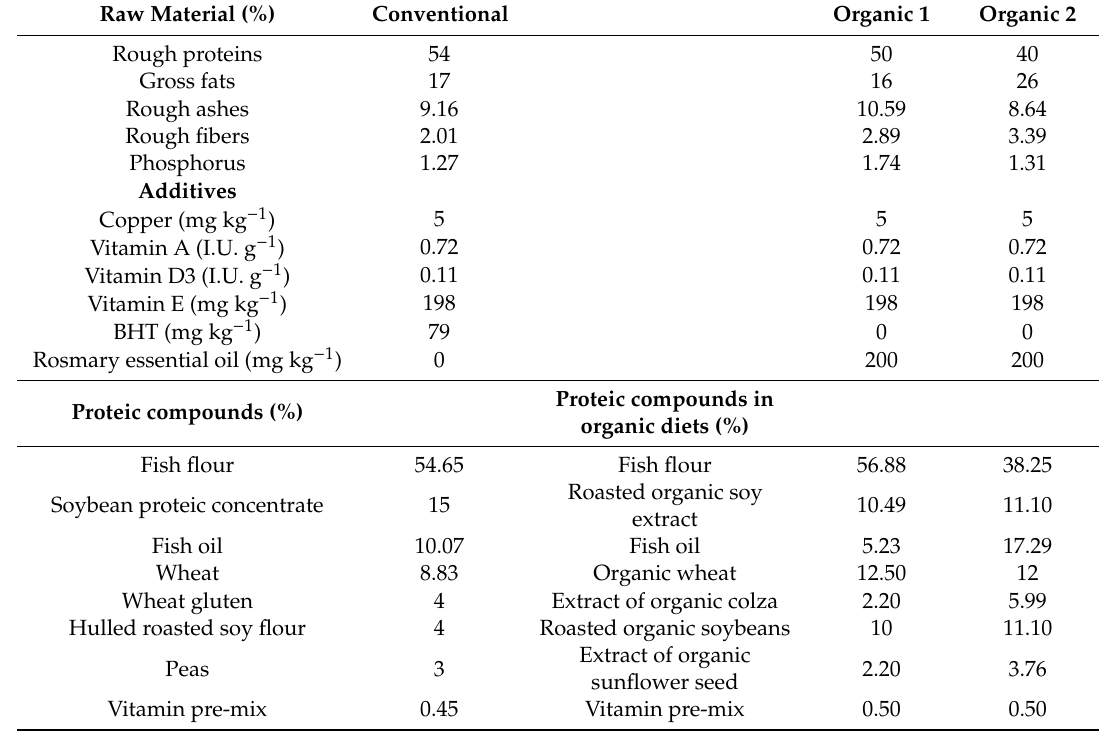
Table 2. Composition of the three experimental diets: conventional (DAN-EX 1754) and two organic diets (Organic diet 1 and 2, DAN-EC 1650 and DAN-EC 2640